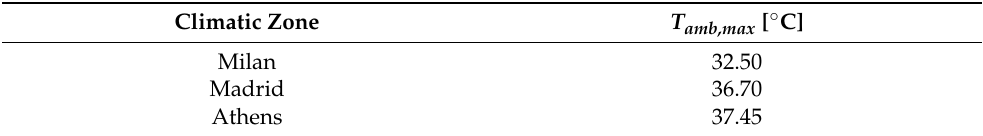
Table 2. Maximum external ambient temperatures for each climatic zone.